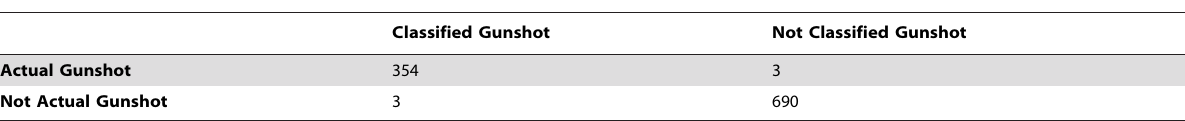
Table 1. Test Sample Confusion